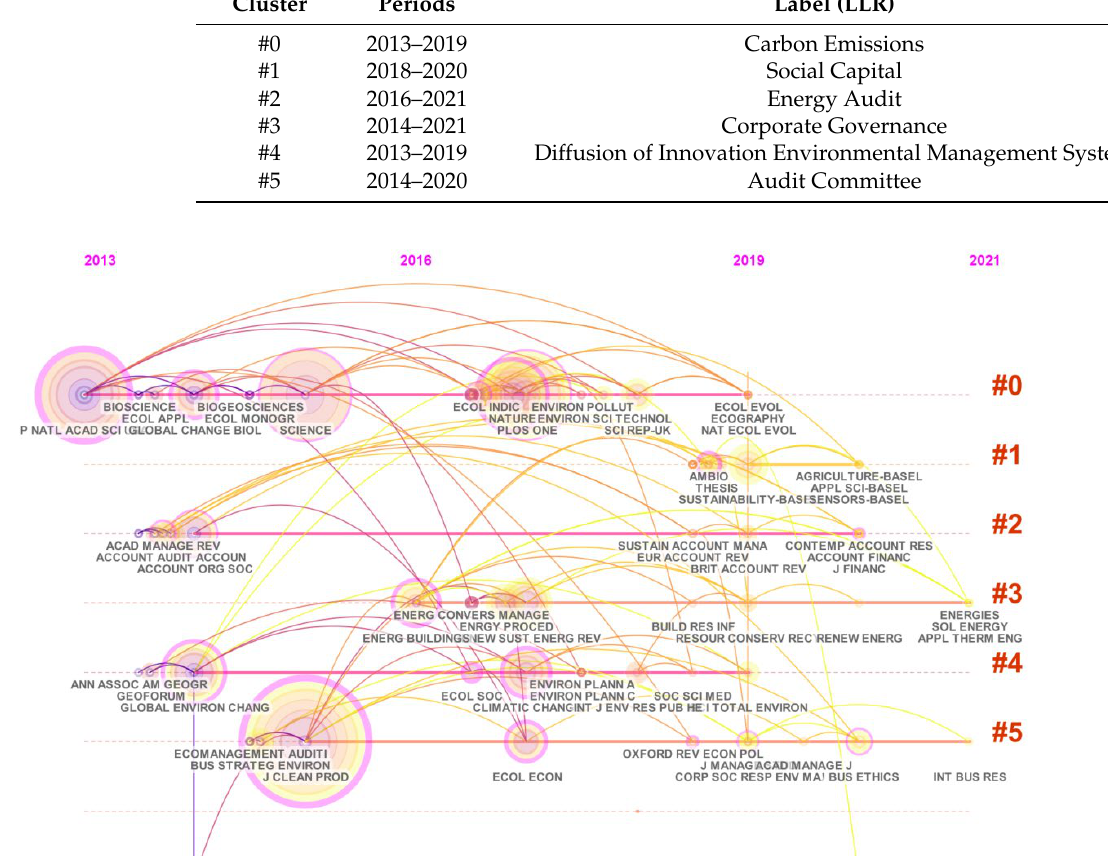
Figure 7. A visualization of the keyword clustering timeline network .